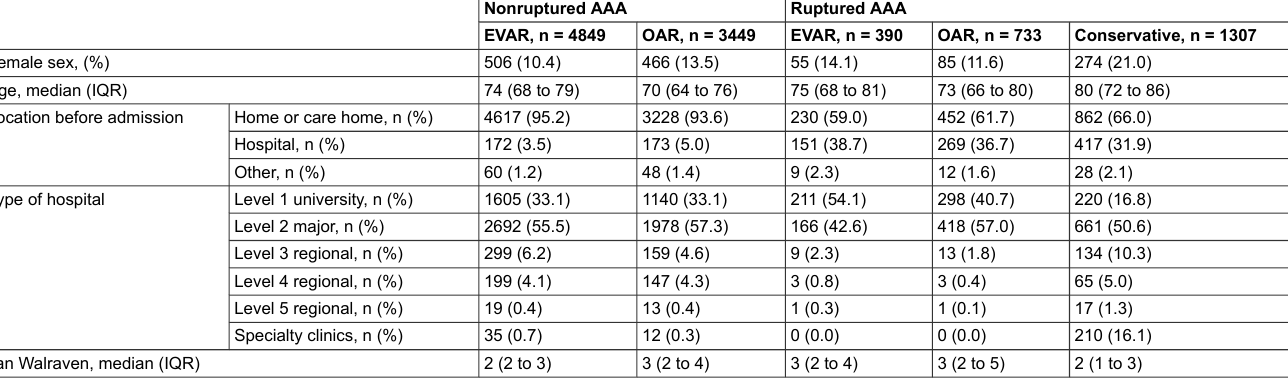
Table 1: Baseline